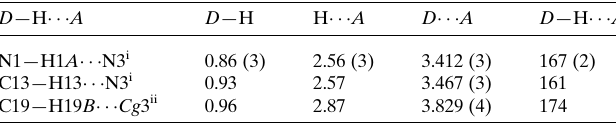
Table 2 Hydrogen-bond geometry (A˚ , (cid:3) ) for (II). Cg 3 is the centroid of benzene ring C8–C13.